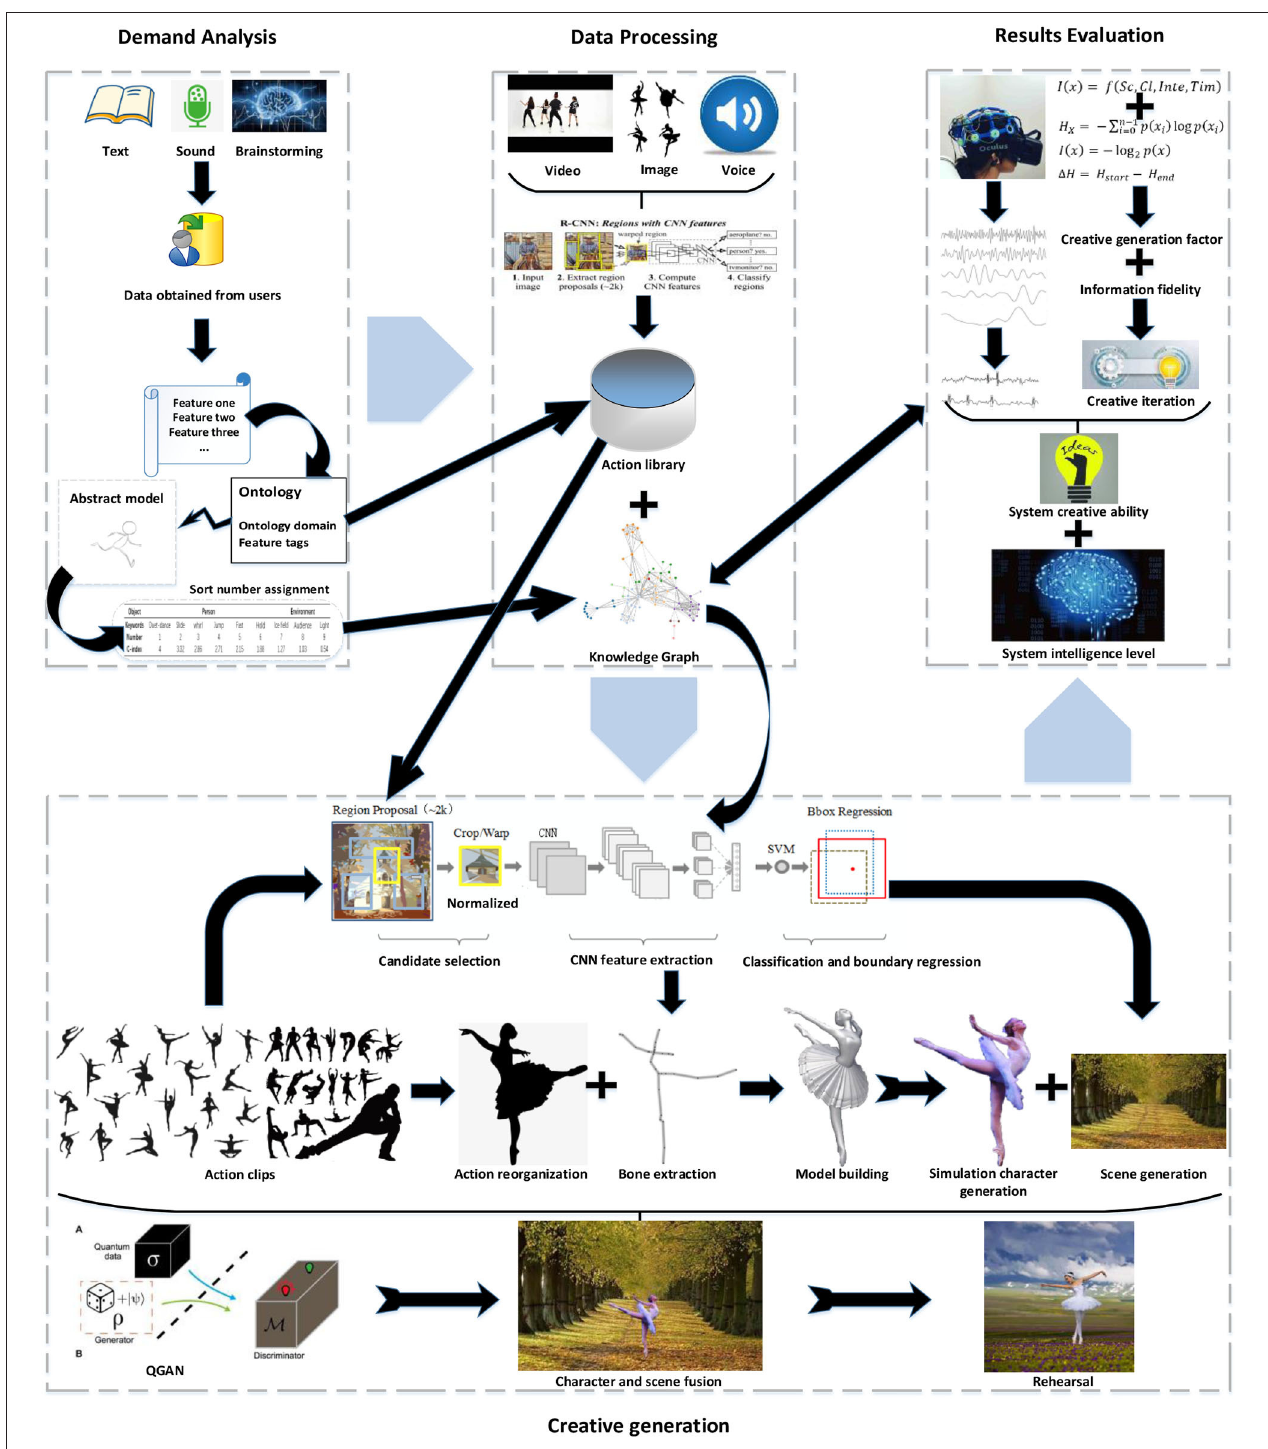
FIGURE 8 | The creative generation model of dance movements integrated with performance scenes. CNN, convolutional neural network; SVM, support vector machines; QGAN, quantum generative adversarial network.